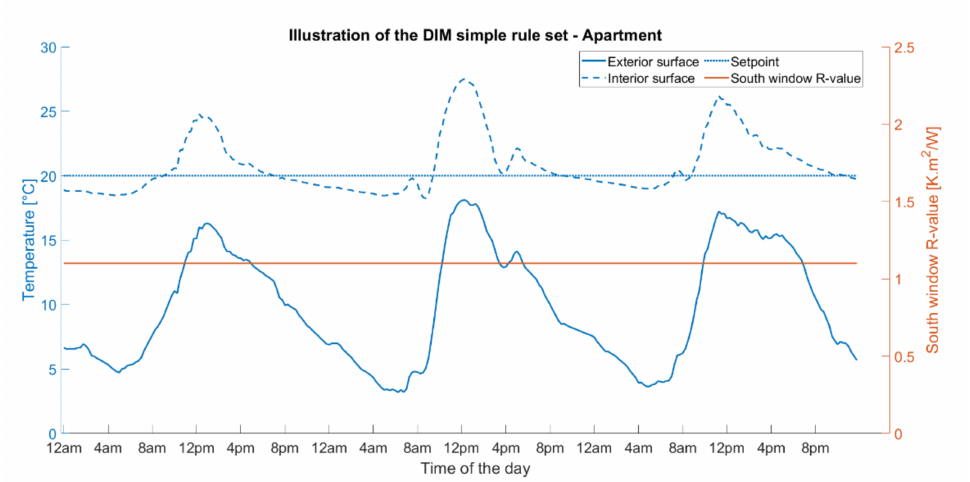
Figure 4. Performance and settings of SIS deployed on the south window during 17 April to 19 April for the apartment unit. For SIS windows, high R-value = 1.1 m 2 · K/W; low R-value = 0.45 m 2 · K/W; high SHGC = 0.4; low SHGC =